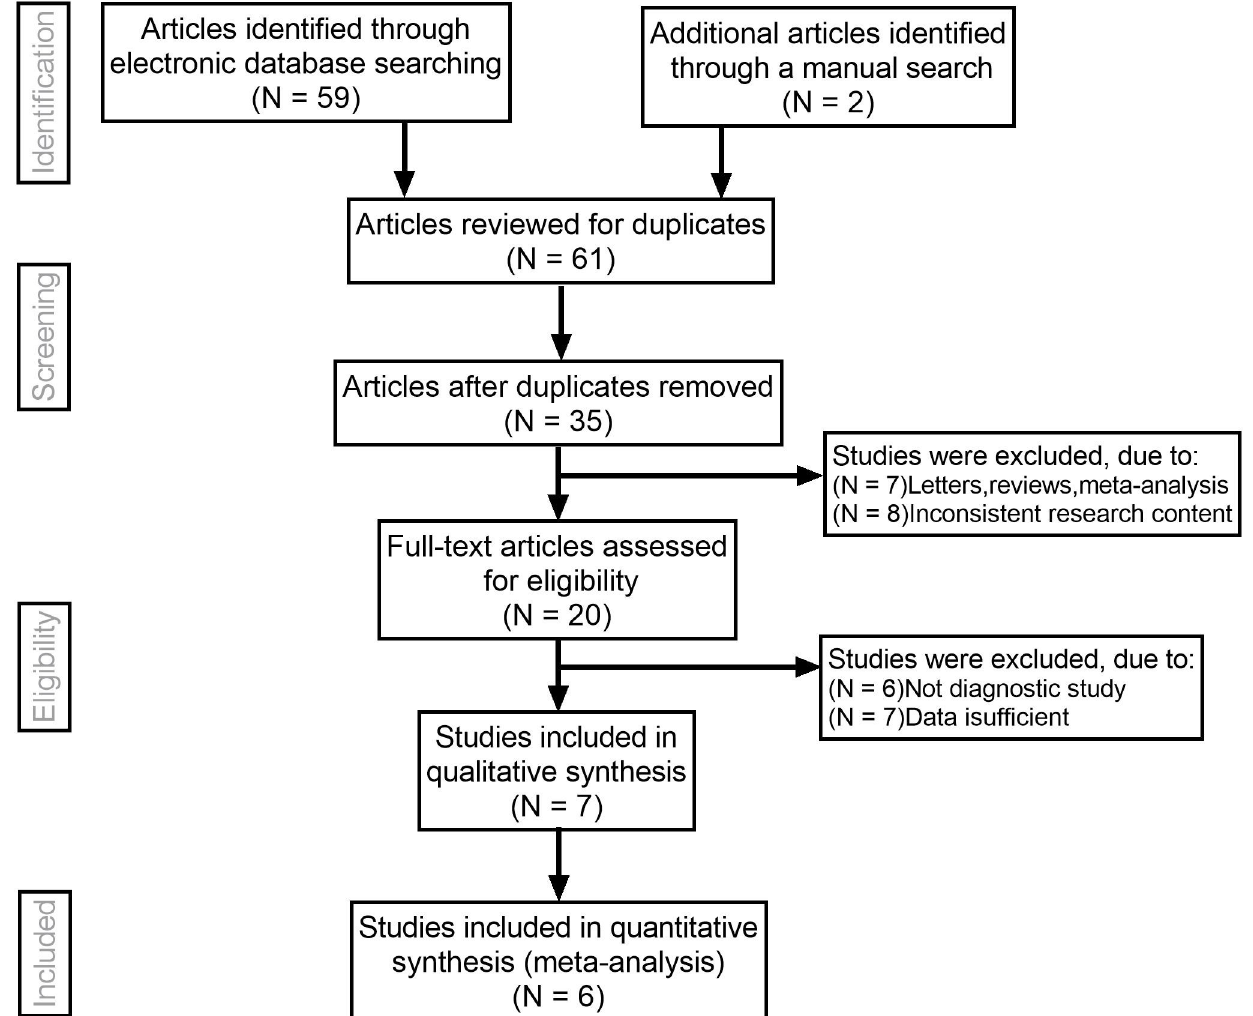
Fig 1. Flow chart of literature search and study selection. Six studies were included in this meta-analysis.